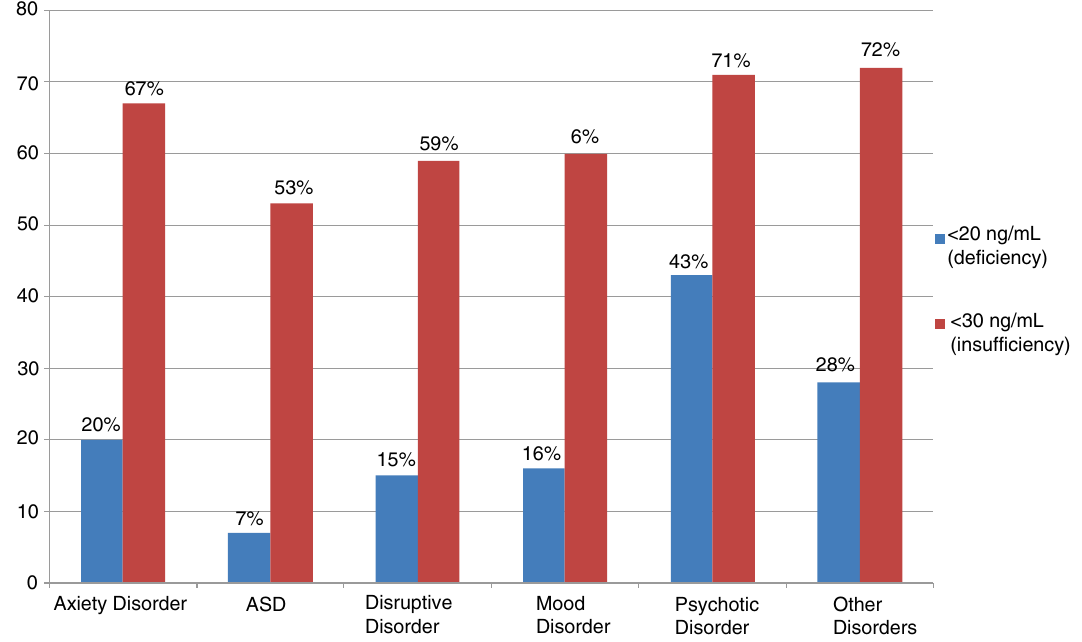
Figure 1. Prevalence of 25(OH)D deficiency (p=0.28) and insufficiency (p=0.72) across diagnostic categories in a pediatric population with mental disorders. See Table 1 for a list of ‘Other